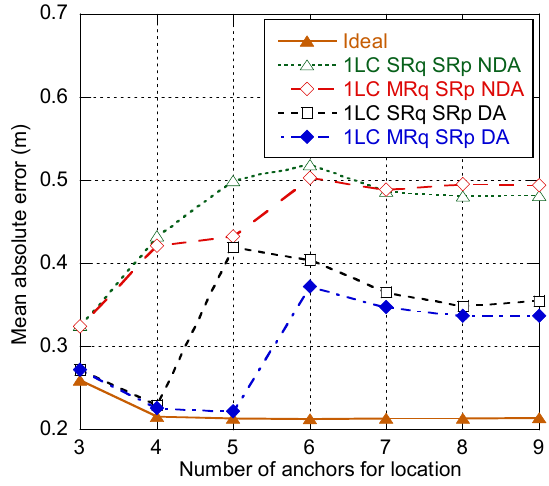
Figure 10. Positioning error for the enhanced